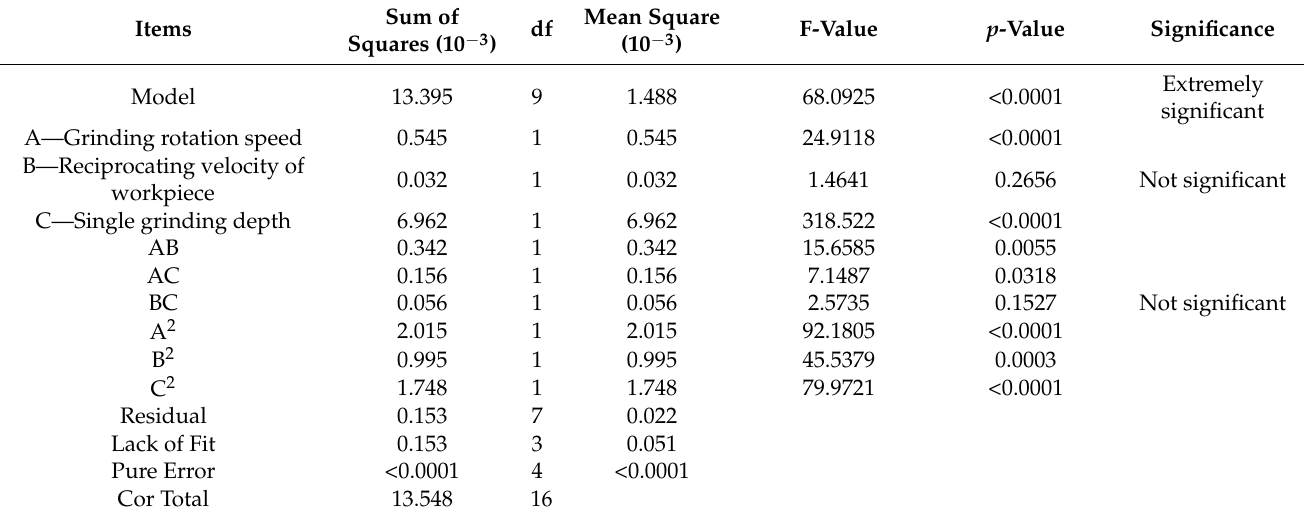
Table 6. ANOVA of experimental